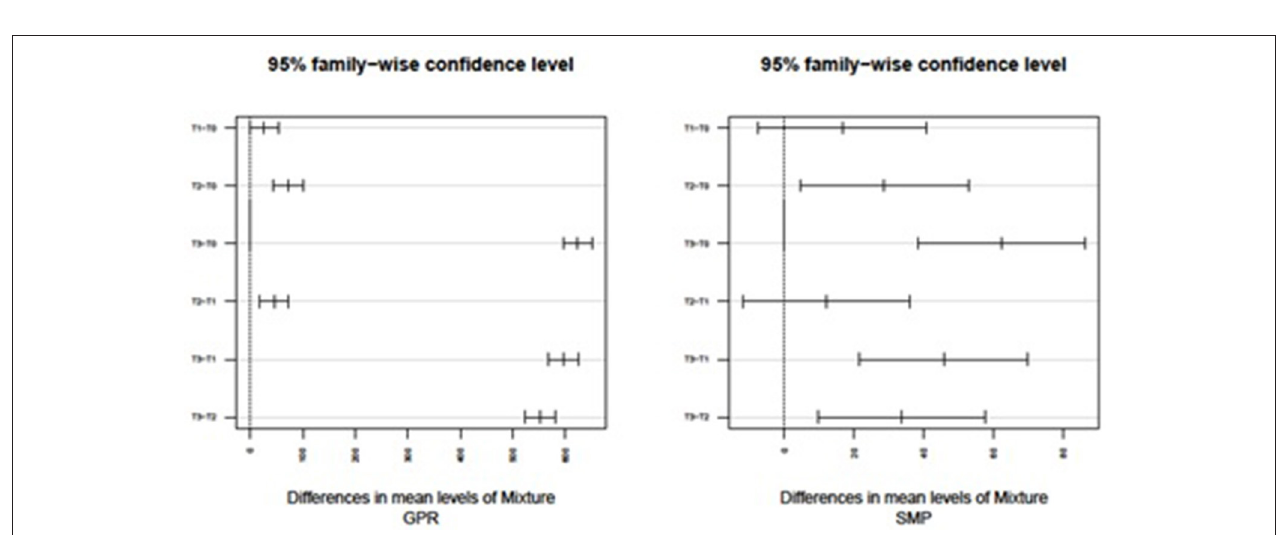
FIGURE 7 | Tukey’s “Honest Significant Difference” confidence intervals for the mean pairwise differences concerning the GPR (on the left) and the SMP (on the right) produced.